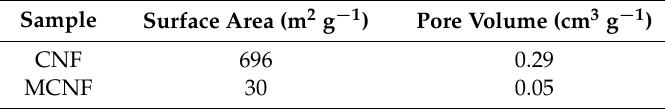
Table 2. The surface area and pore volume of CNF and